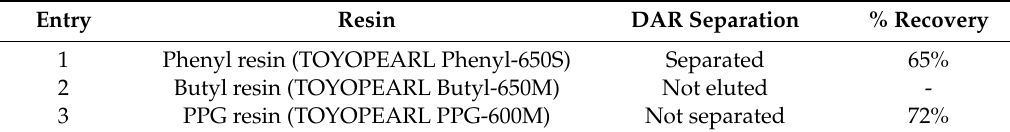
Table 1. Resin screening for trastuzumab-AJICAP ™ -MMAE.